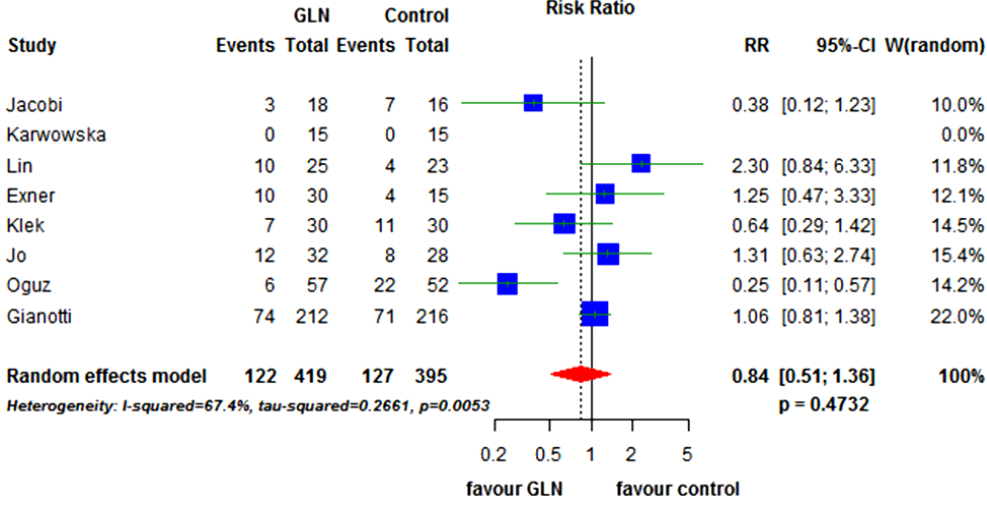
Figure 4. Forest plot for overall morbidity comparing GLN vs. control. GLN: glutamine, RR: relative risk, CI: confidence